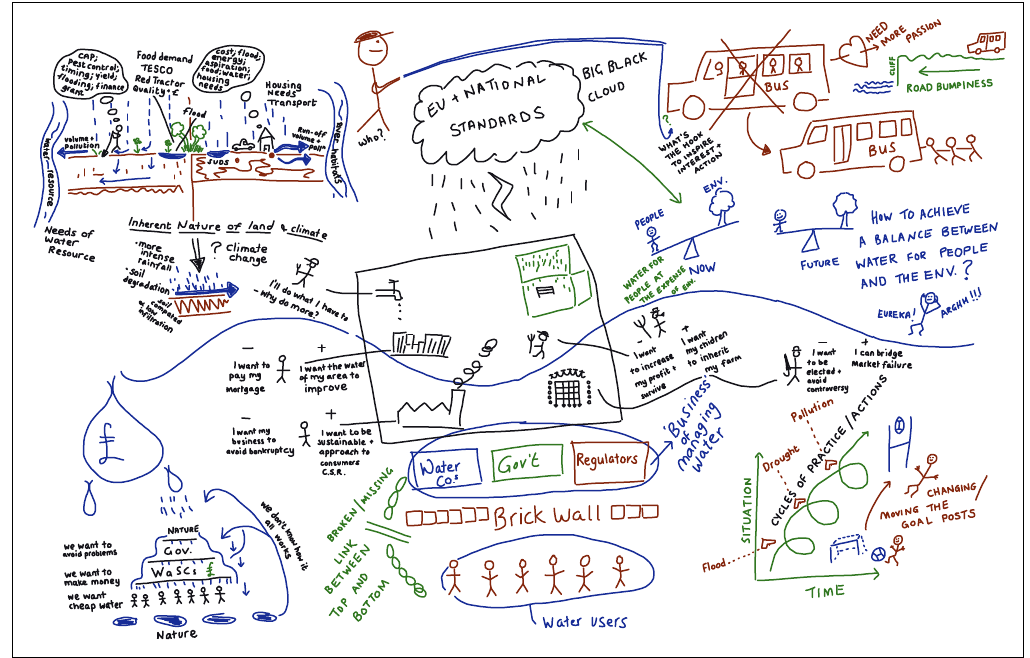
Figure 1. A rich picture of the current water governance situation in England drawn by a group of workshop participants (redrawn from the version created at the workshop; see also Figure S1)